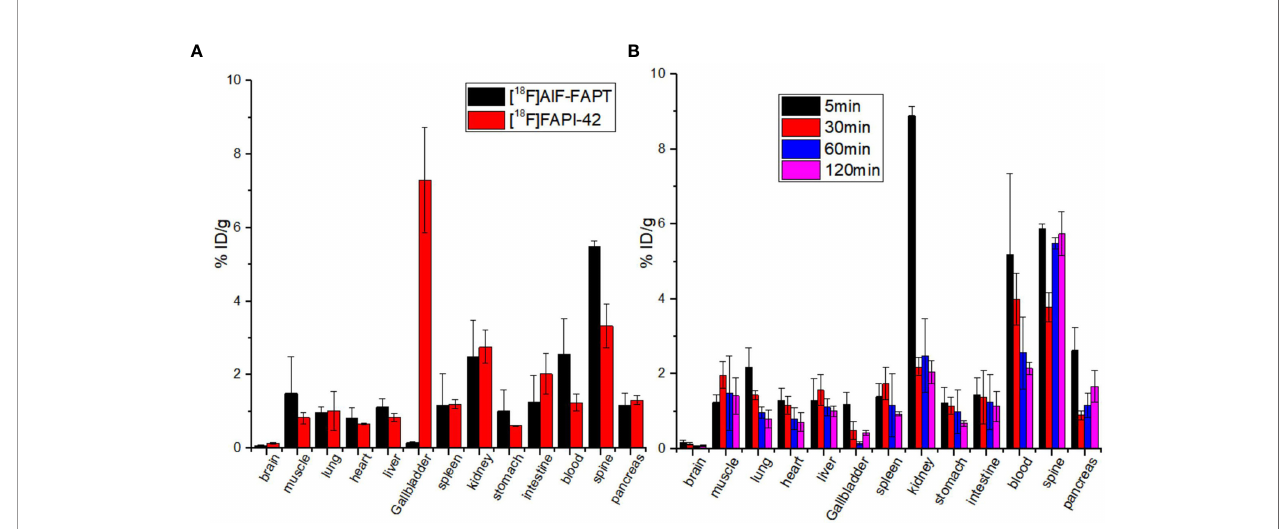
FIGURE 4 | Biodistribution study of [ 18 F]AlF-FAPT and [ 18 F]FAPI-42 at different tissues. (A) The biodistribution of [ 18 F]AlF-FAPT and [ 18 F]FAPI-42 at 60 minutes; (B) The biodistribution of [ 18 F]AlF-FAPT at different time